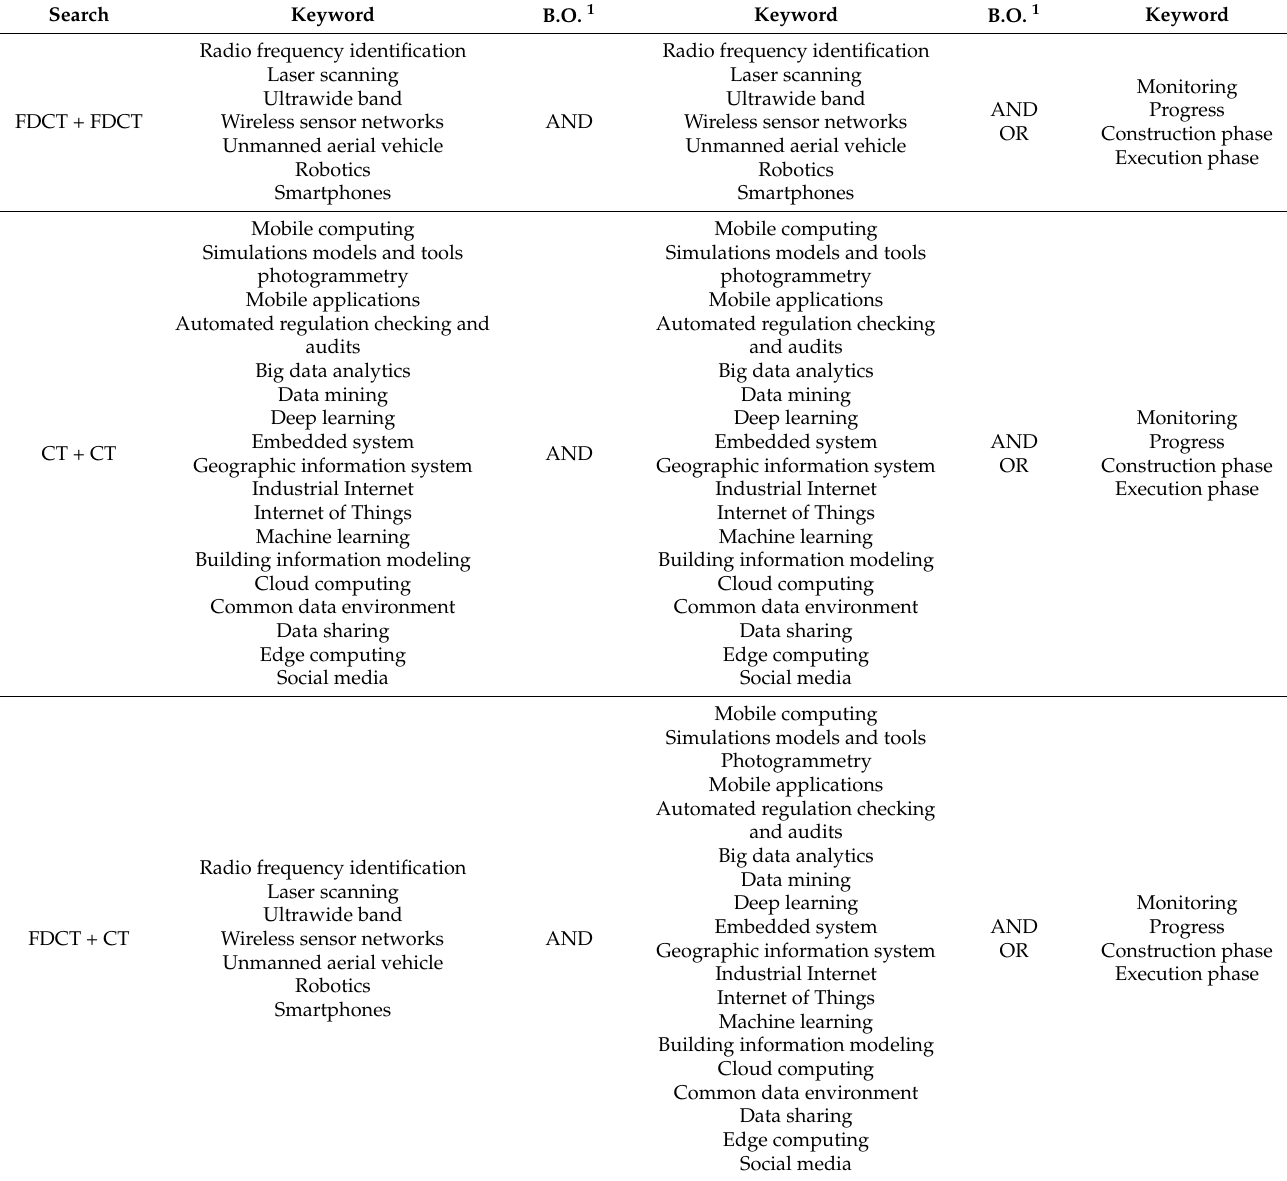
Table 1. Keywords and Boolean operators used to identify relevant